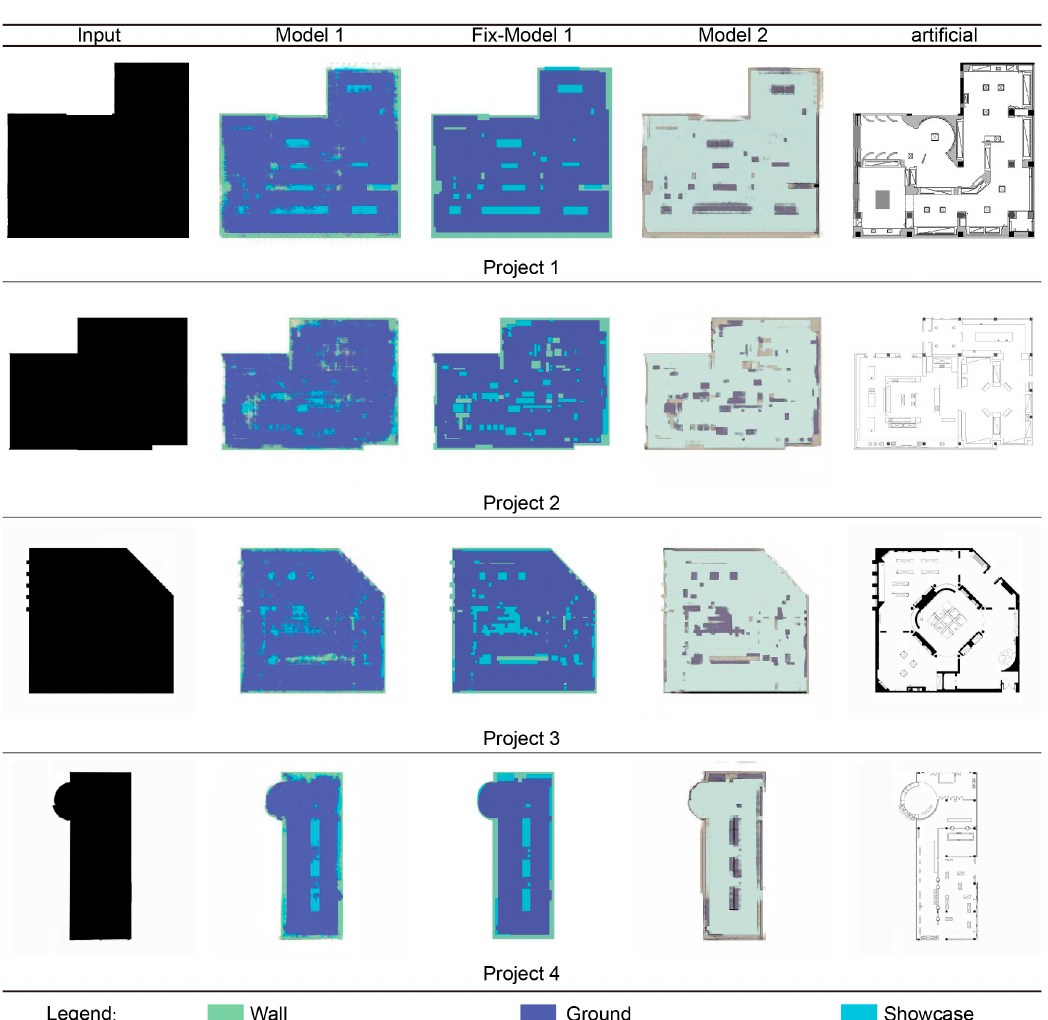
Figure 8. Comparative analysis of differences with architects’ designs.